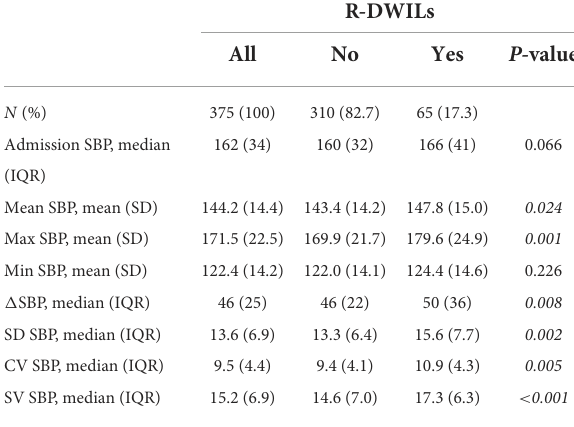
TABLE 2 Comparison of SBP profiles between patients with and without